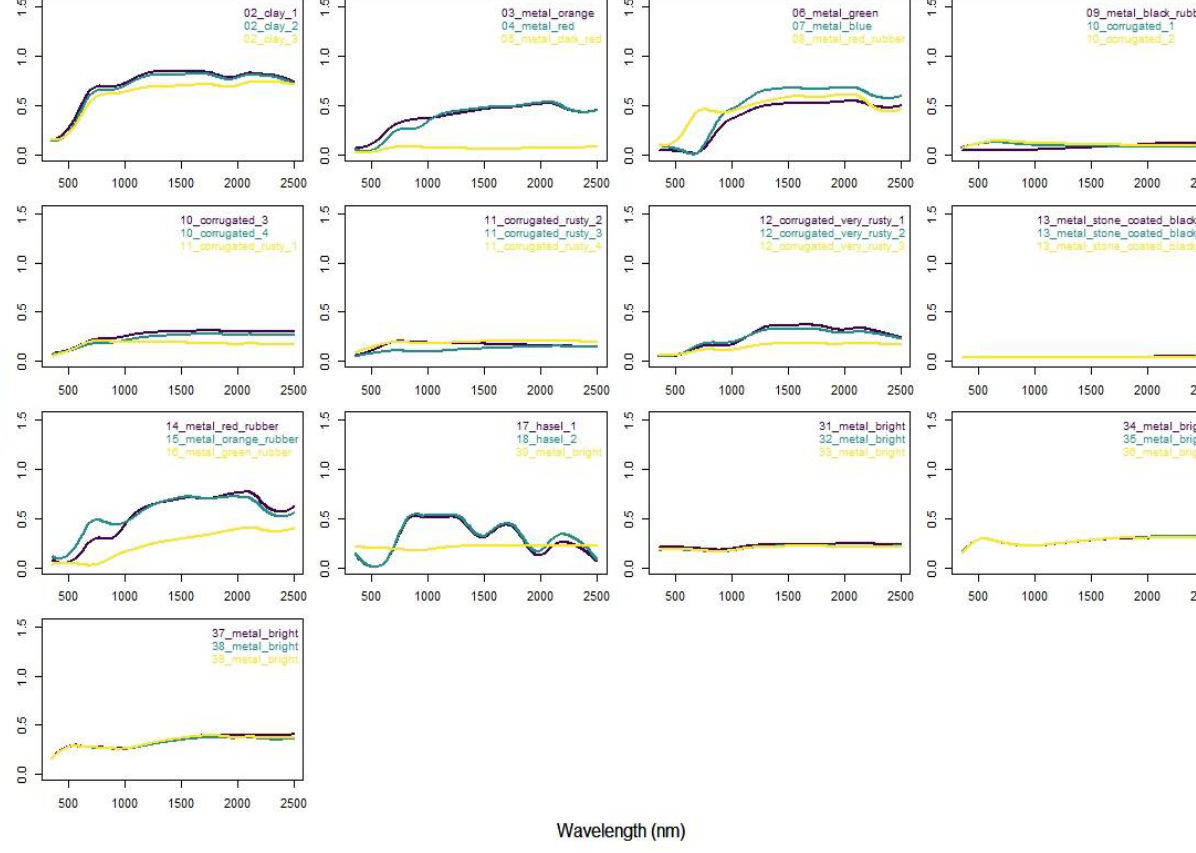
Similarly, the “hsdar” package (Lehnert et al., 2018) is also used for pre-processing and processing of hyperspectral data. In this study, we mainly used the “spectralresampling” function to resample the spectral resolution of the field spectrometer (1 nm) to the bandwidths of the satellite sensor (DESIS), for this is a prerequisite for the mesma